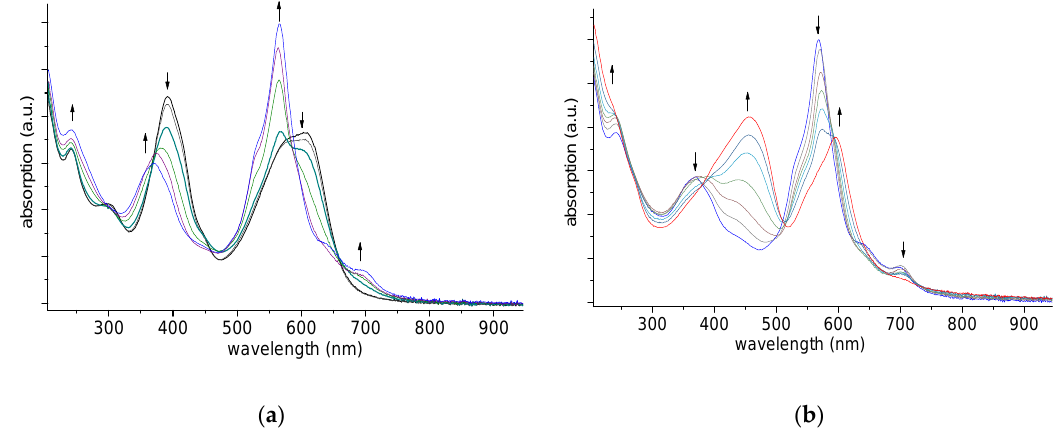
Figure 6. UV-Vis absorption spectra recorded during cathodic reduction of [Ni 4 (L i Pr ) 4 ] in THF/ n Bu 4 NPF 6 solutions. ( a ) Spectra recorded at E = 0 and from − 1.5 to − 1.9 V; ( b ) spectra recorded from E = − 2.0 to − 2.6 V.